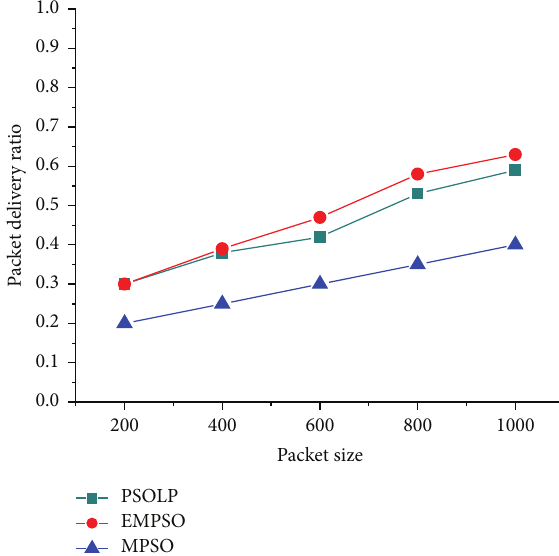
Figure 2: Packet delivery ratio versus packet